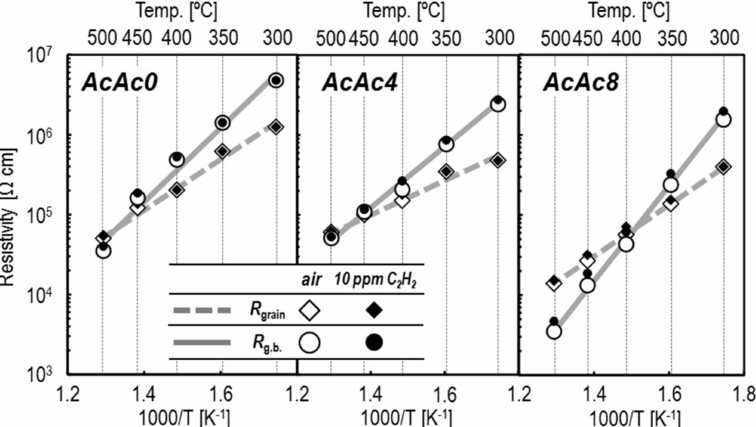
Figure 8. Temperature dependencies of resistivity of grain and grain boundary [g.b.] for the SmFeO 3 thin-film devices at 300–500 ◦